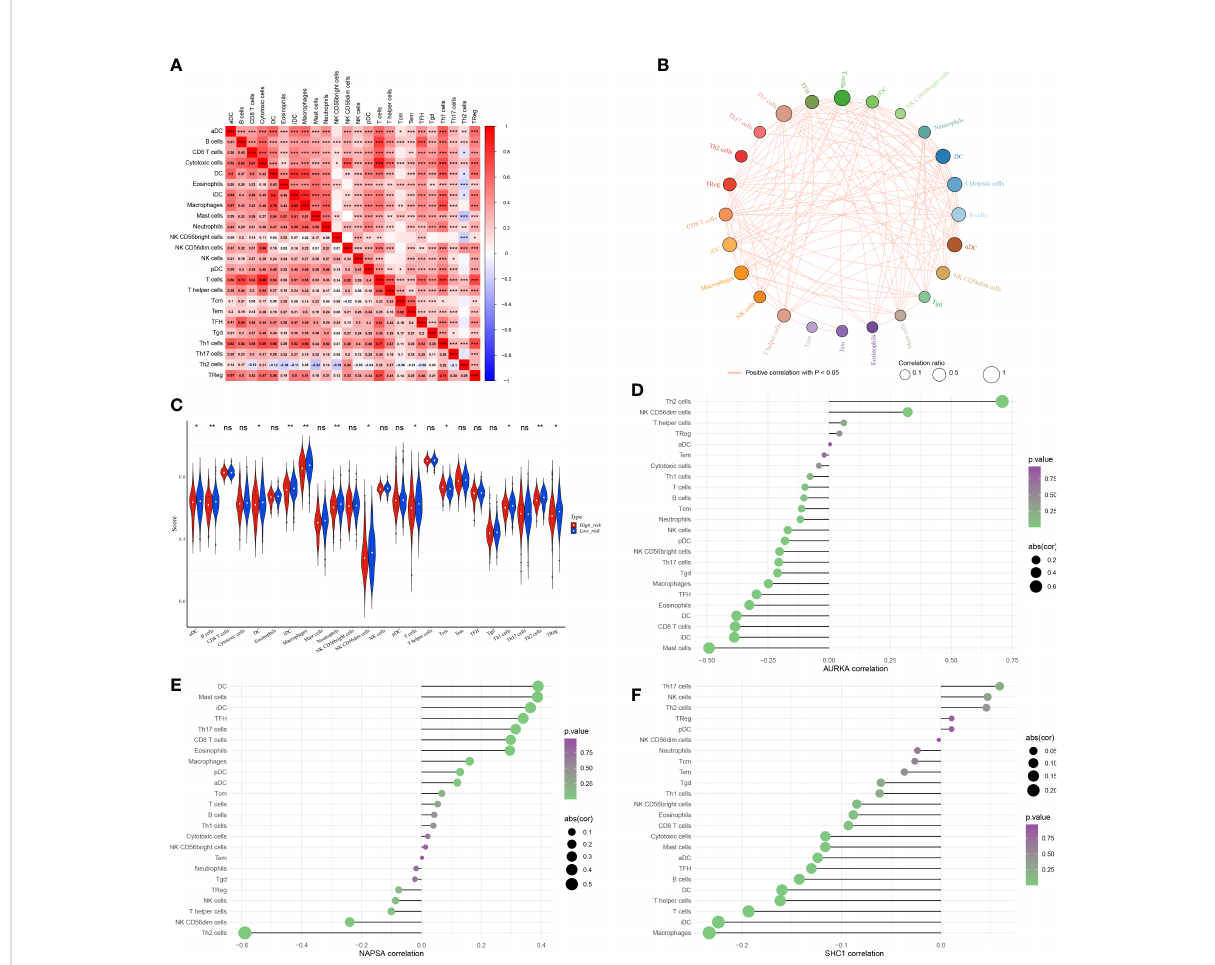
FIGURE 9 The immune microenvironment was different between the low and high-risk groups. (A) Heat map of immune cell correlation analysis in the high and low-risk groups. (B) Immunocellular correlation analysis Net plot of the high and low-risk groups. (C) Immune cell in fi ltration in the high and low-risk groups - Violin diagram. (D – F) AURKA, NAPSA , and SHC1 prognostic biomarker genes, and immune cell correlation. *p < 0.05, **p < 0.01, and ***p < 0.001. "ns" indicates P value ≥ 0.05, not statistically signi fi